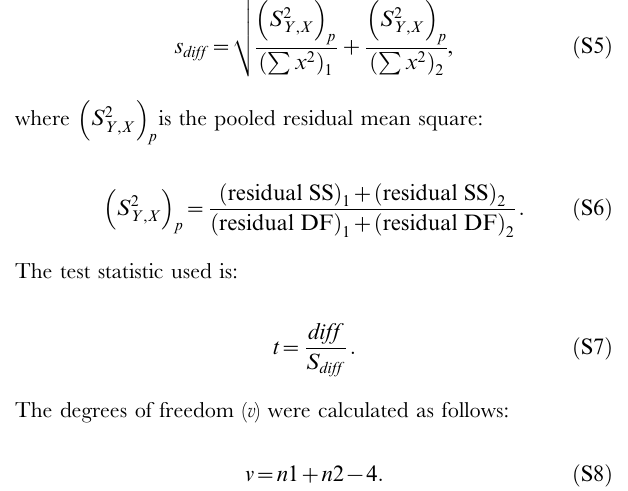
Figure S4 Individual cone feedback responses in various pharmacological conditions. (A) Application of 500 m M